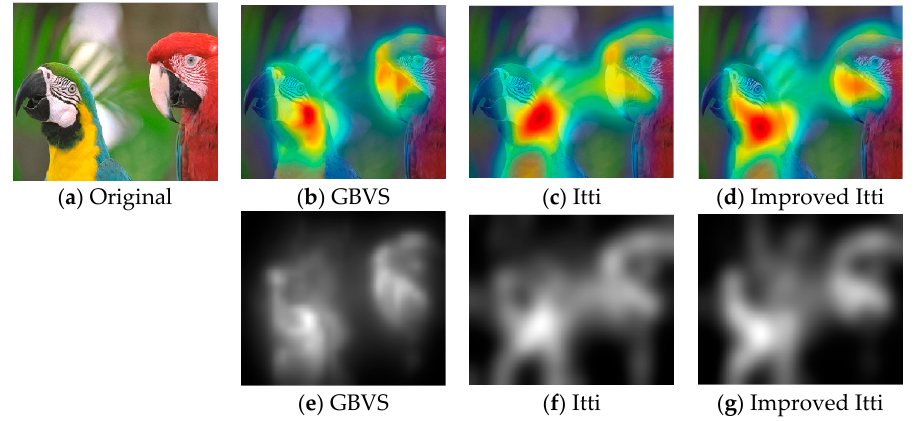
Figure 9. Comparison of different visual saliency models. ( a ) Original image; ( b – d ) salient overlap maps of GBVS model, Itti model and improved Itti model respectively; ( e – g ) salient maps of GBVS model, Itti model and improved Itti model respectively.